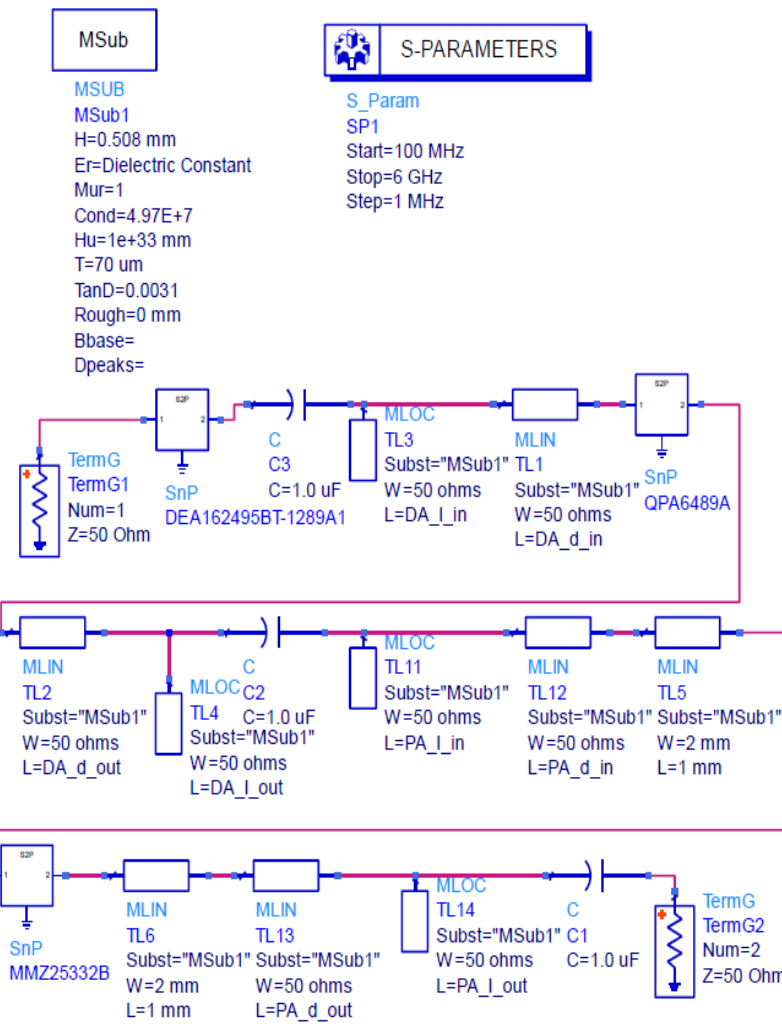
Figure 3. Model and simulation of signal conditioning stage designed for each substrate carried out in ADS software.